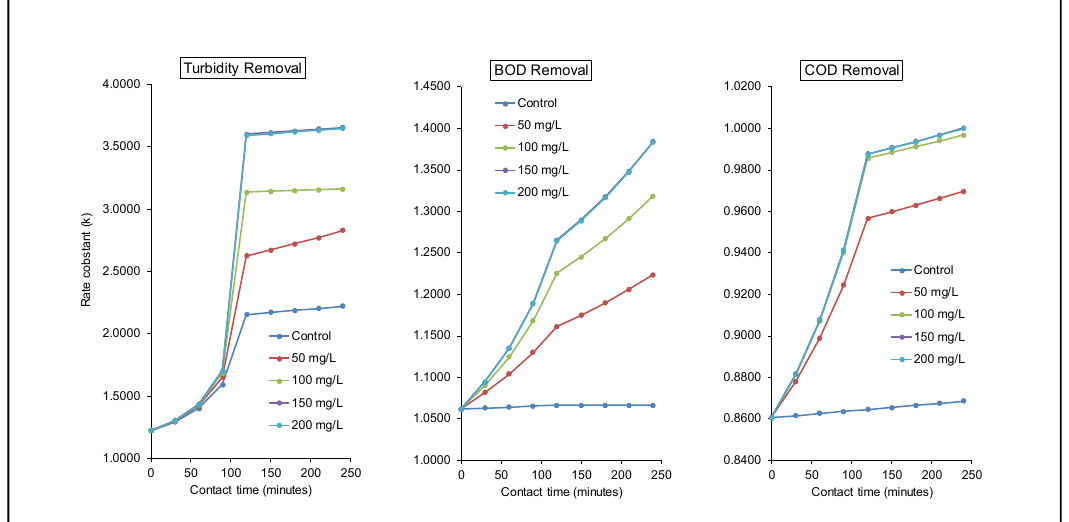
Figure 3. The first-order rate constant ( r ) of cumulative turbidity (NTU min − 1 ), BOD (mg / L · min − 1 ), and COD (mg / L · min − 1 ) removal of municipal wastewater using MO coagulant.